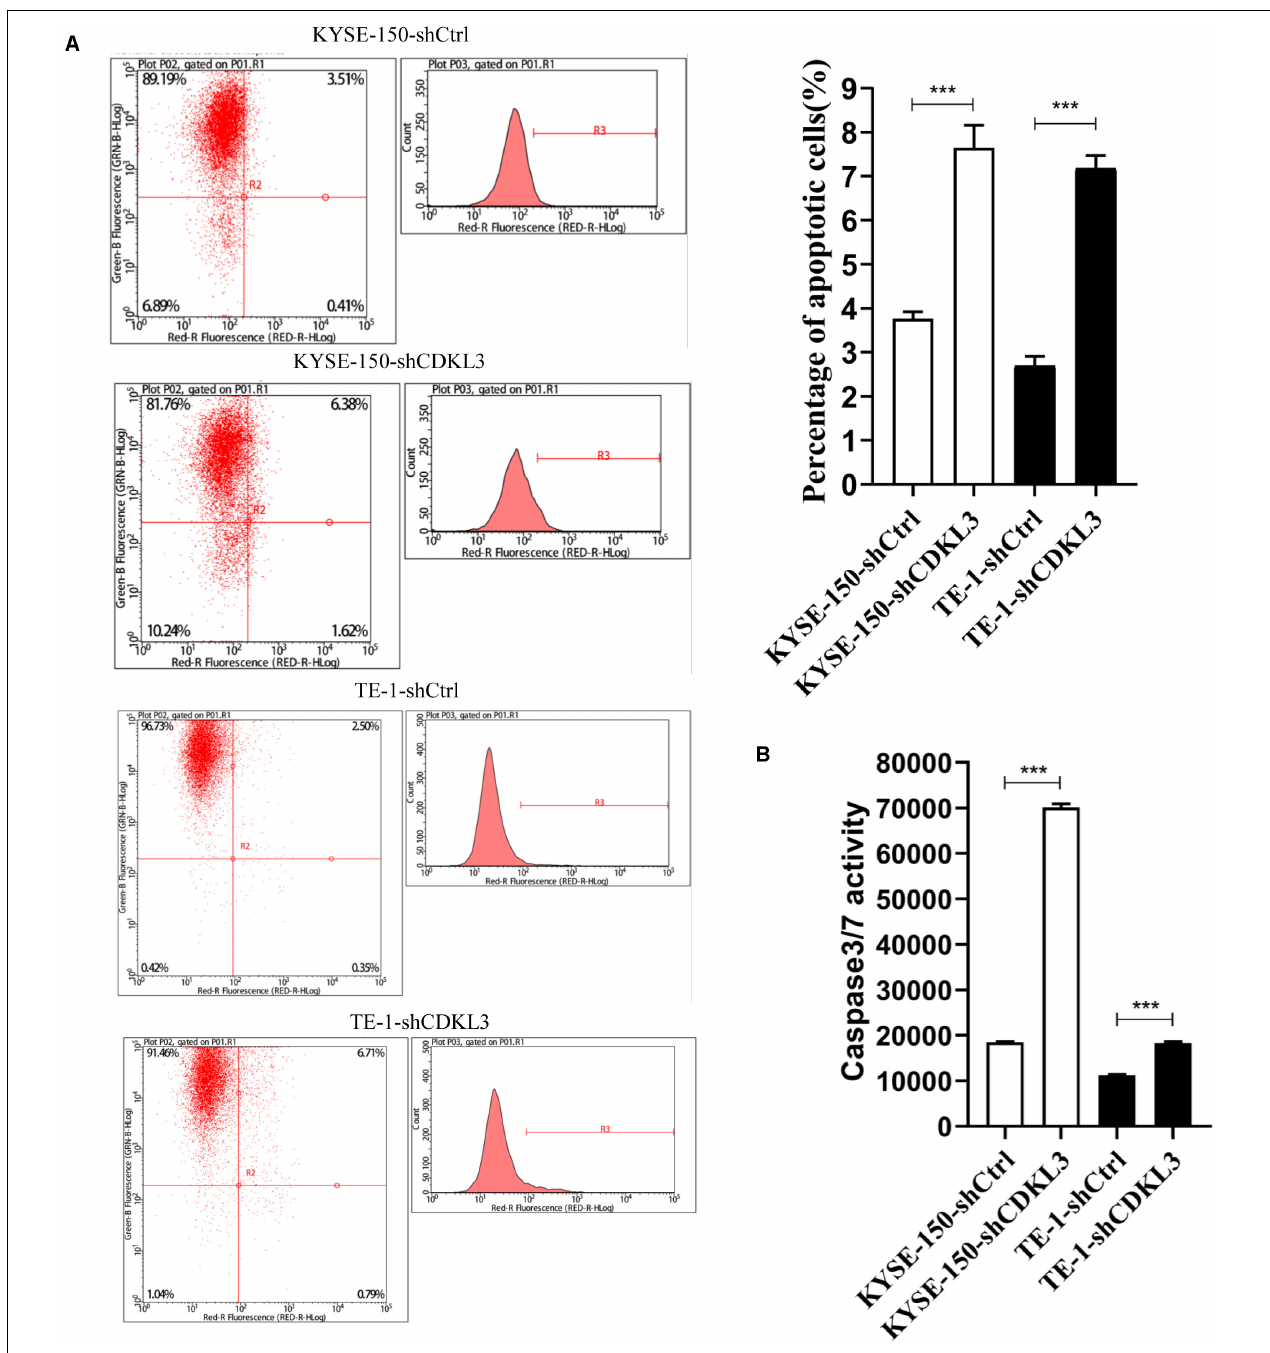
FIGURE 2 | Knockdown of CDKL3 increased apoptosis in TE-1 and KYSE-150 cells, which was measured by Annexin-V-APC and caspase 3/7 assay. (A) Early apoptotic cells (Annexin-V+) were displayed in the upper and lower right quadrant. Knockdown of CDKL3 increased the early apoptotic rates in TE-1-shCDKL3 and KYSE-150-shCDKL3 cells. (B) Knockdown of CDKL3 remarkably enhanced caspase-3/7 activity in TE-1-shCDKL3 and KYSE-150-shCDKL3 cells. Data were represented as the mean ± SD of three separate experiments, *** P < 0.001.